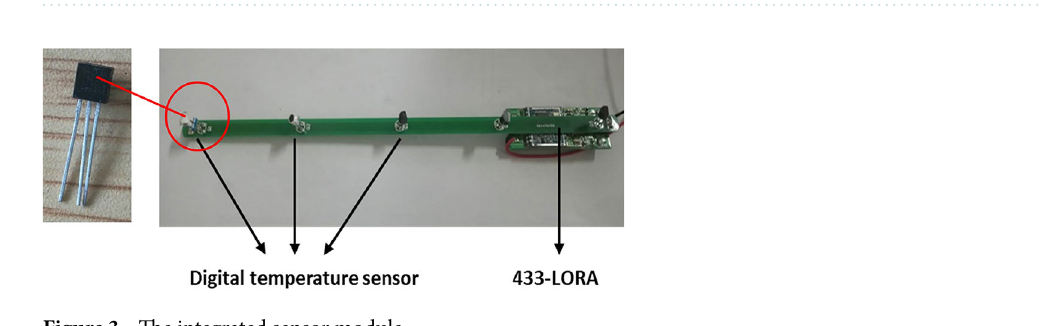
Figure 2. Comparison of heat dissipation of cutterhead before and after mud cake formation (Generated by Microsoft PowerPoints 2016).